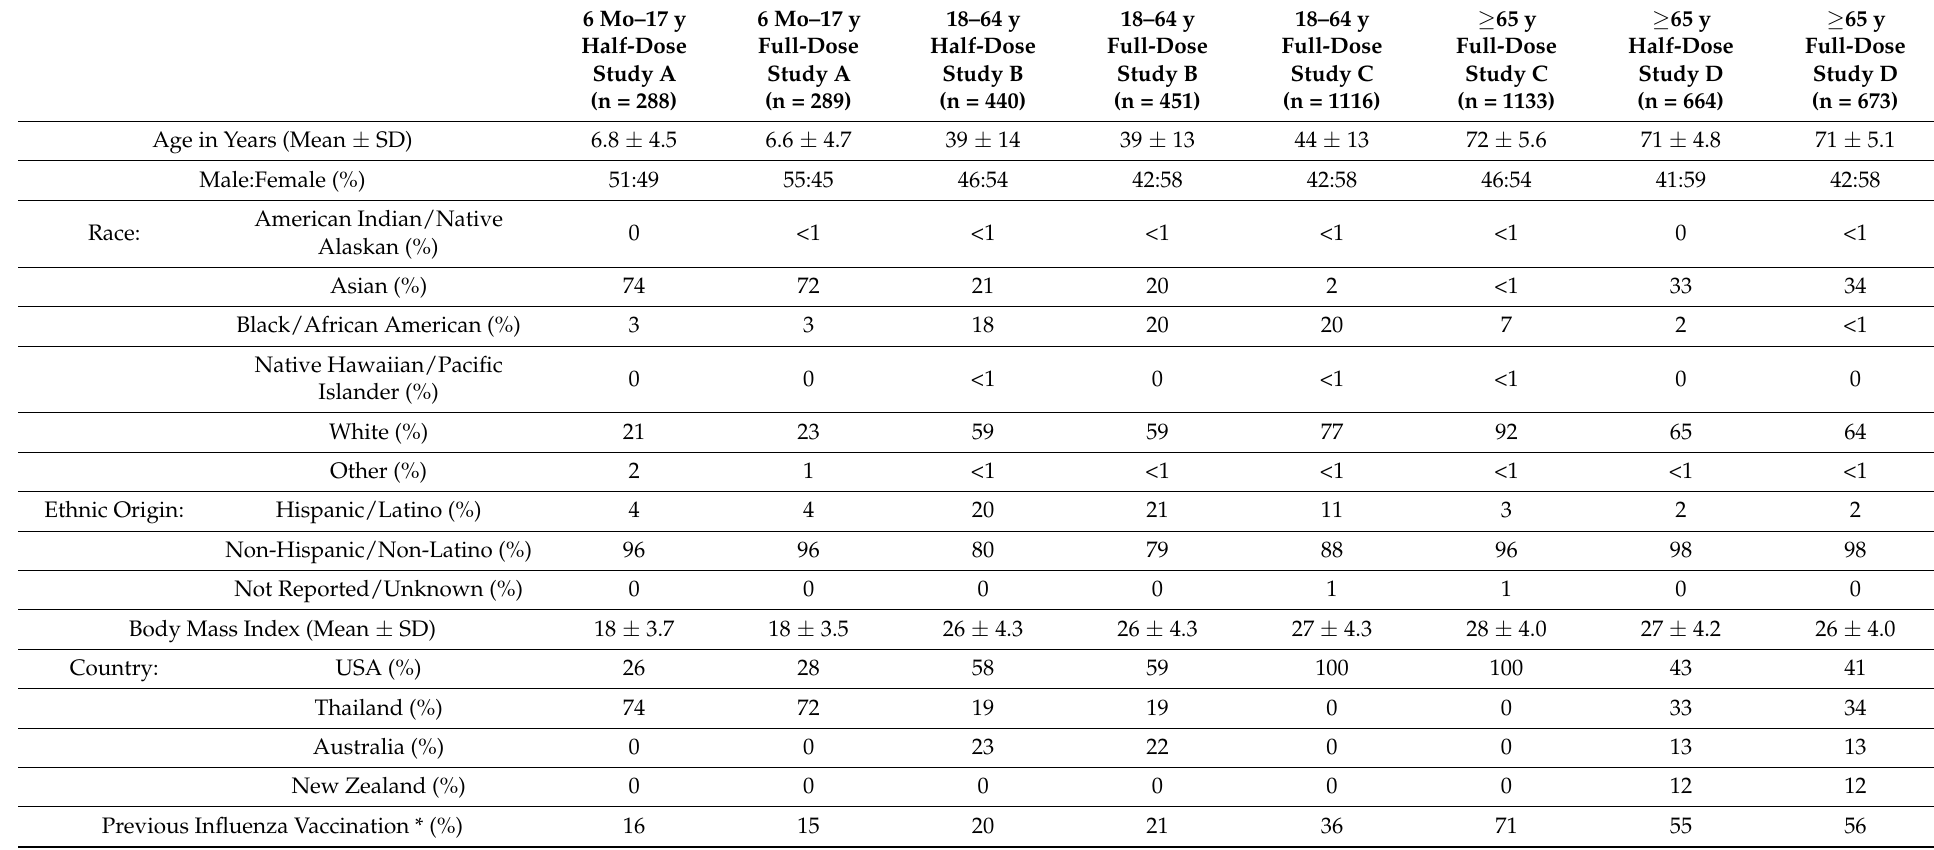
Table 1. Population demographics and baseline characteristics in aH5N1c vaccine